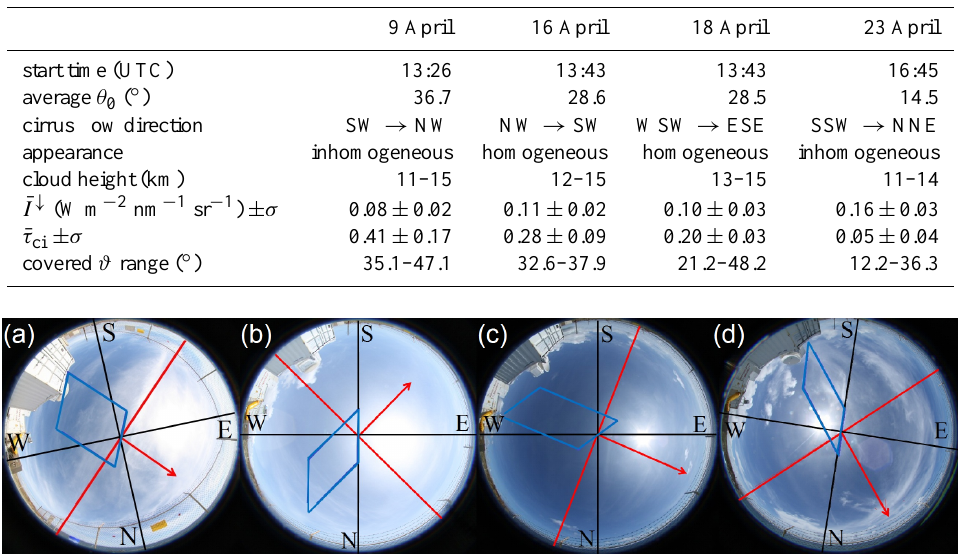
Table 1. Characteristics of the evaluated measurement periods.